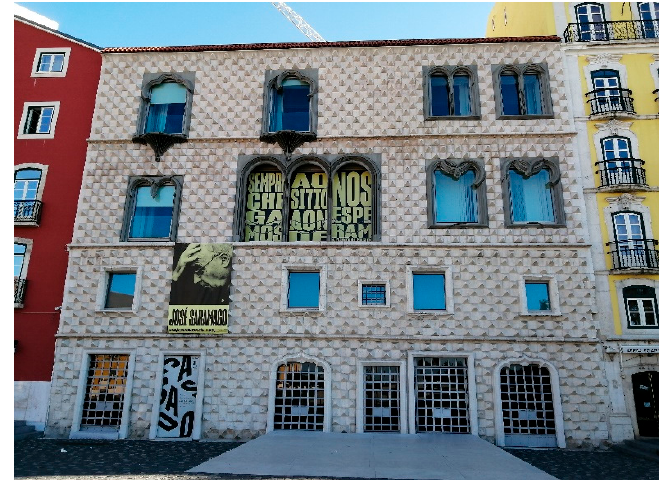
Figure 12. Damage classification caused by the tsunami on churches, other buildings and the overall damage on each civil parish at the study area. The list of churches and buildings is given in the caption of Figure 10.